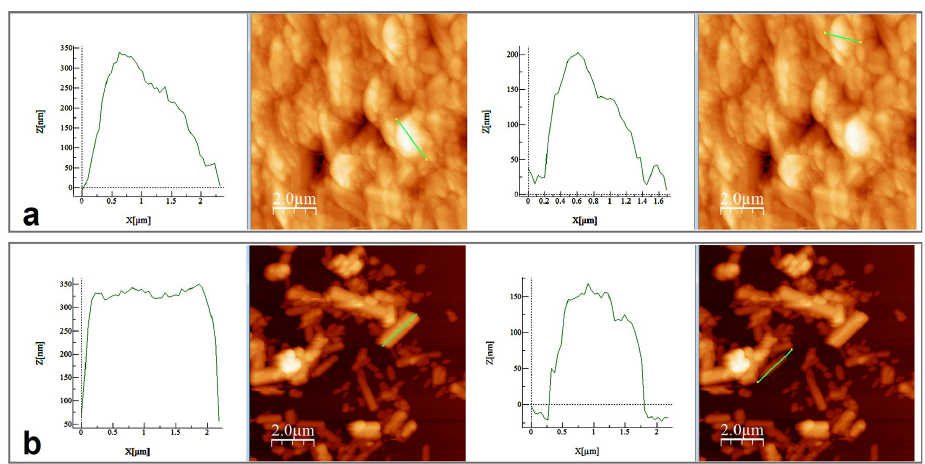
Figure 8. Height and width measurements on the selected area for S LowTP ( a ) and for S HighTP ( b ).